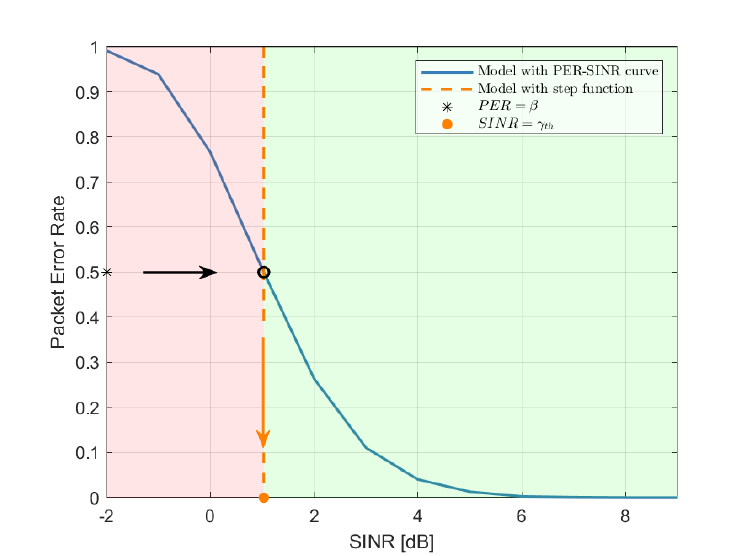
Figure 2. From the PER vs. SINR curve (solid blue) to the approximating step function (dashed orange). The asterisk is the target PER value β and the orange point indicates the corresponding SINR threshold γ th . Adopting the step function, the packet is assumed as successfully received if the SINR is higher than the threshold (light green part), and not received otherwise (light red part).